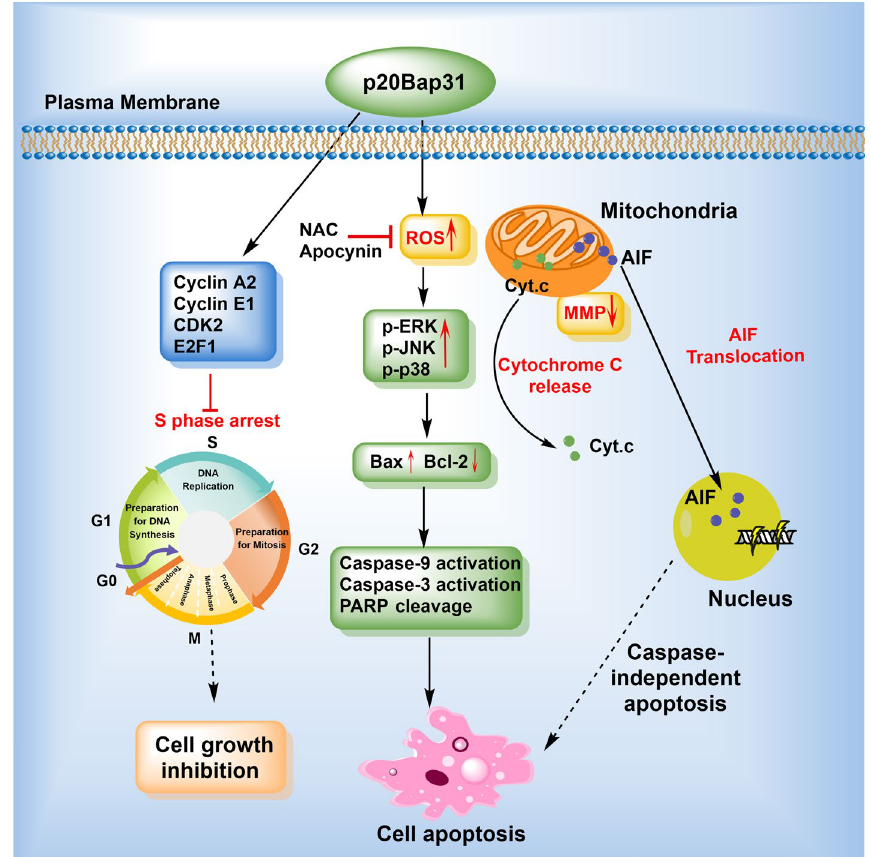
Fig. 8 Schematic drawing of the proposed mechanisms of p20BAP31-induced apoptosis. See text for